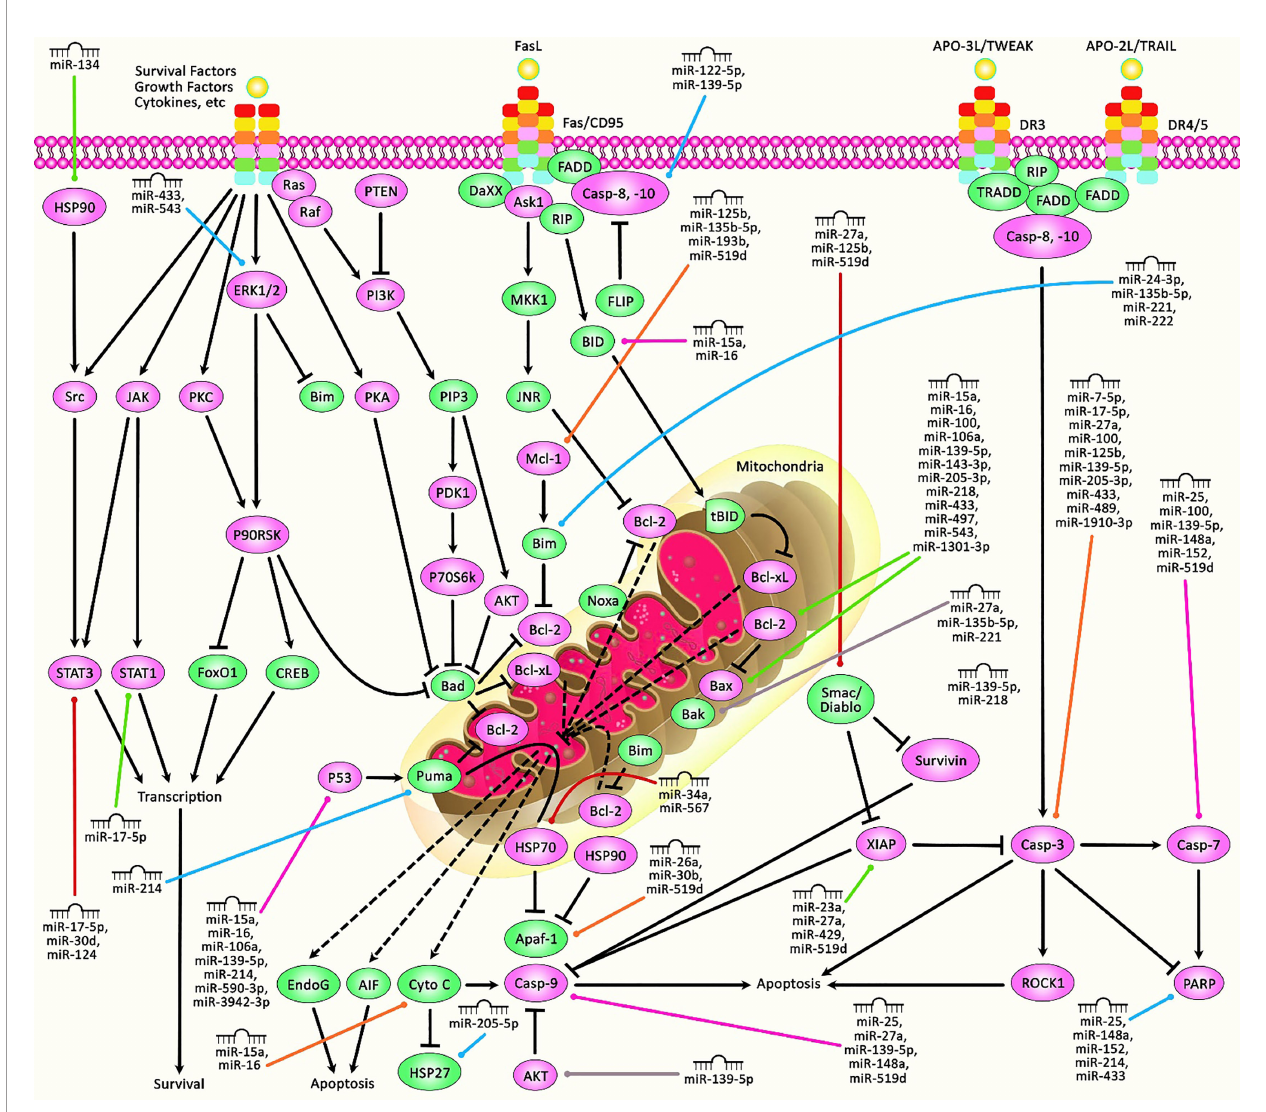
FIGURE 1 | A schematic diagram of the role of miRNAs in triggering the mitochondrial cascade of apoptosis in human breast cancer. Apoptosis pathway could be activated via both extrinsic and intrinsic cascades. The intrinsic pathway is generally occurring through the release of cytochrome c from the mitochondria and modulates mitochondrial outer membrane permeabilization via Bcl-2 family proteins. The activation of extrinsic cascade could be triggered via ligand binding to death receptor, including DR3, DR4, DR5, Fas, and TNF a R. Following that, caspase proteins have a signi fi cant part in cleaving target proteins as well as nuclear lamins to elevate DNA degradation, leading to apoptotic cells undergoing phagocytosis. Furthermore, P53, via triggering the upregulation of various proteins containing Bid, Bax, CD95, Puma, and TRAIL-R2, could get effectively involved in activating intrinsic and extrinsic apoptosis cascades. Therefore, any alterations or abnormalities occurring during apoptotic pathways could considerably contribute to the progression of human diseases, including cancer. Previous studies have authenticated that several miRNAs could have a crucial role in regulating the apoptosis pathway in breast cancer. All the information regarding the role of these miRNAs involved in the modulation of breast tumors can be seen in Table 1